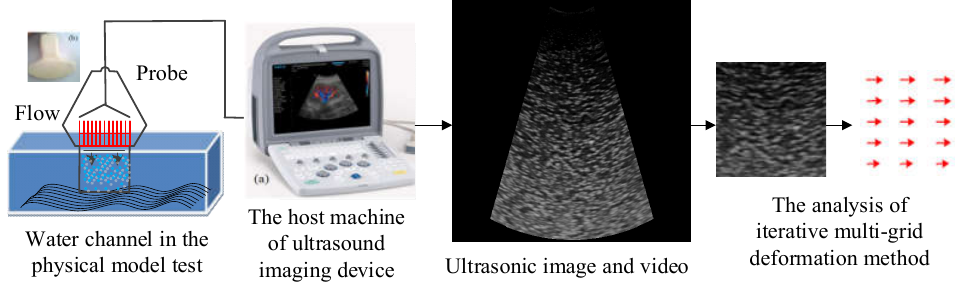
Figure 1. The analysis process of ultrasound PIV system in silt carrying flow.